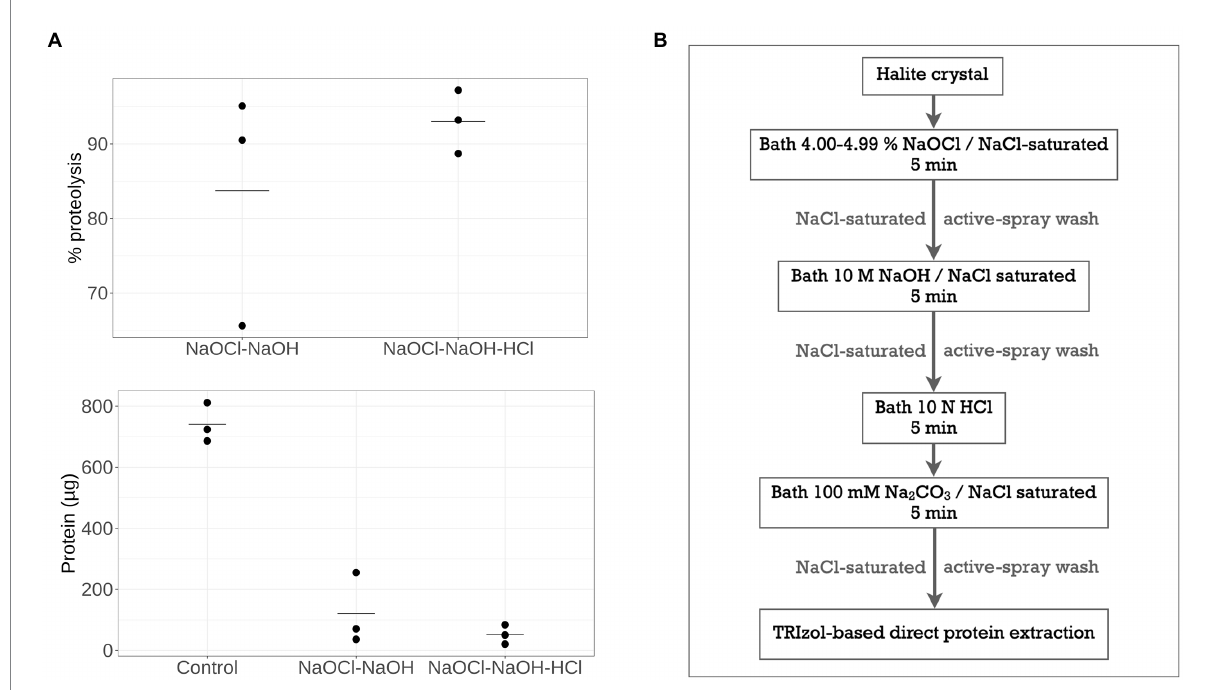
FIGURE 3 Surface-bounded protein removal by chemical treatments with active-spray washes. (A) Percentage of proteins removed after NaOCl-NaOH treatment with or without an additional HCl treatment step, and subsequent residual protein quantity. (B) Overview of optimal NaOCl-NaOH-HCl chemical treatment with active-spray